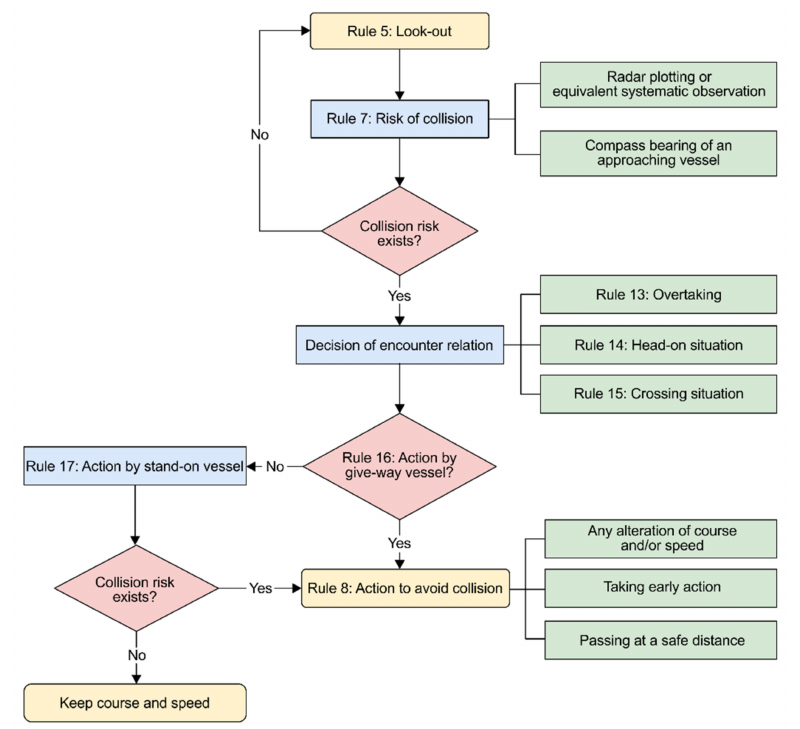
Figure A1. Procedure for collision avoidance based on COLREGs ([3]. 2022, Namgung,